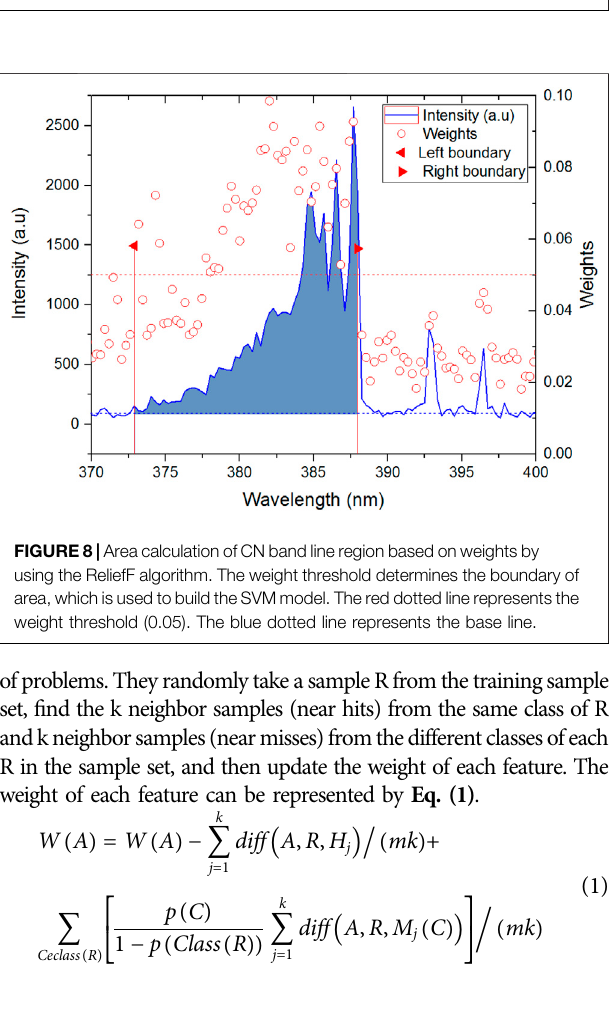
FIGURE 7 | Two-dimensional mapping of intensities of line regions with high weights (A) CL-20, (B) HMX, (C) RDX, (D) fl our, (E) talcum powder, (F) PTFE.